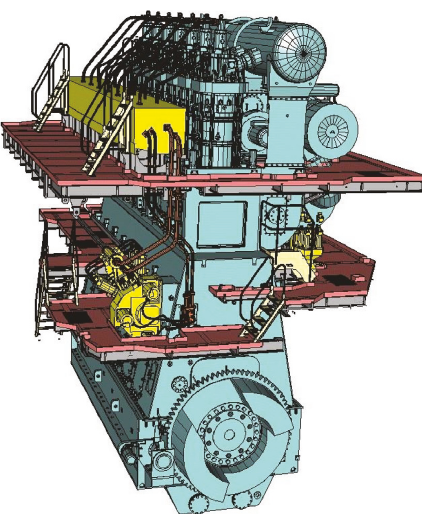
Figure 6: WARTSILA 5RT-flex35 model drawing.